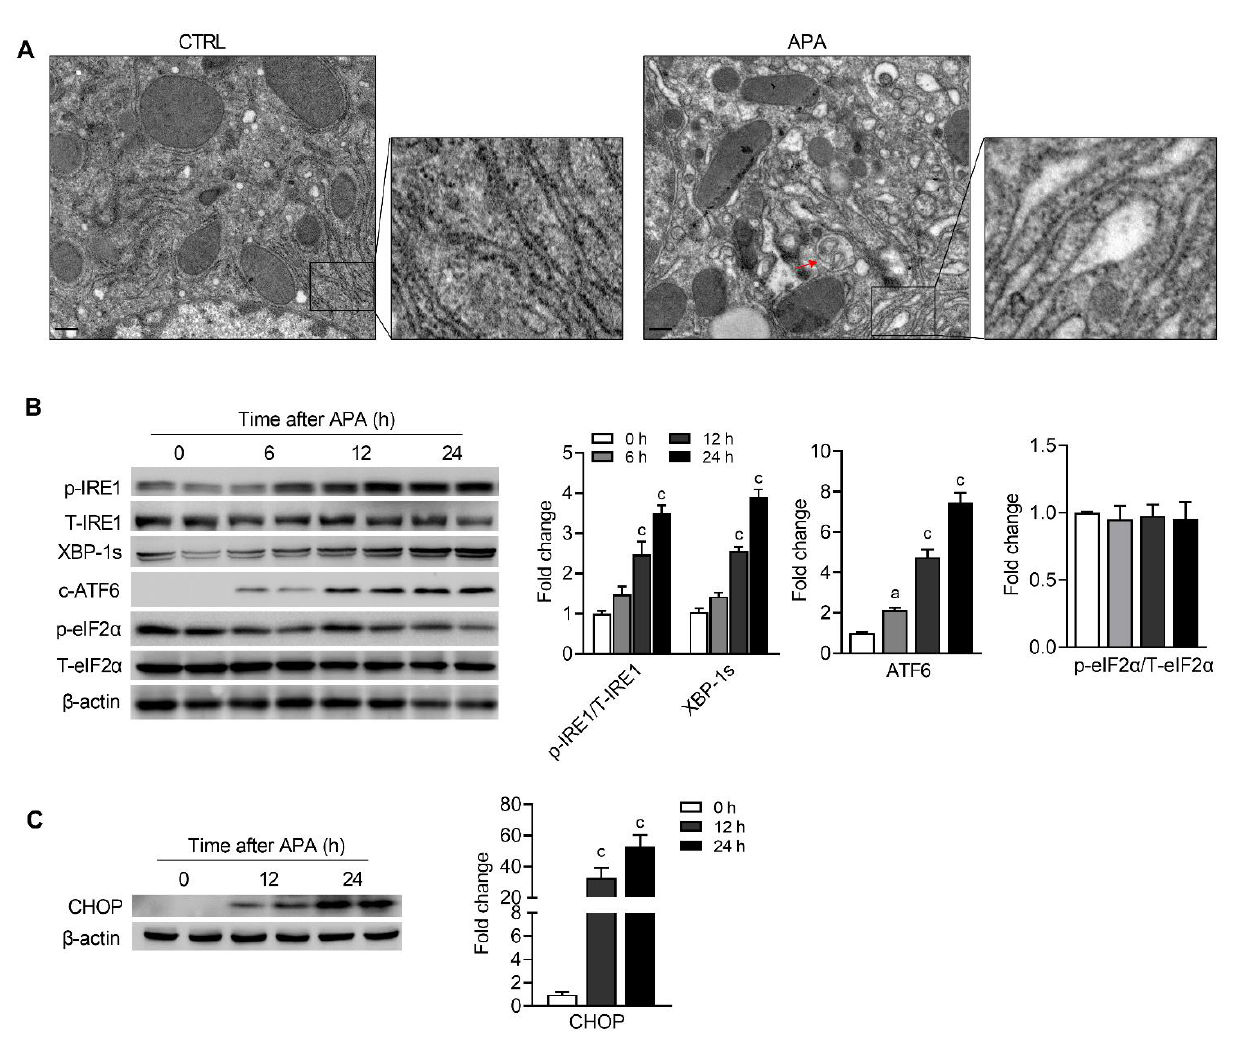
Figure 2. ER-phagy is activated and is accompanied with an unfolded protein response in APA hepatotoxicity. Mice were fasted for 16 h before injection with PBS or APA (300 mg/kg). At 6, 12 and 24 h post-APA, liver tissues were collected. ( A ) Representative TEM images of hepatocytes in mice liver at 24 h following PBS or APA injection. Scale bar = 400 nm. Arrows denote ER-selective autophagosomes. Immunoblot analysis for ( B ) p-IRE1, total IRE1, the sliced XBP-1, the cleavage of ATF6, p-eIF2α, total eIF2α and ( C ) CHOP at the indicated time points. Quantification of the phosphorylated proteins normalized to the corresponding total proteins bands, with the other protein bands normalized to the respective β-actin bands and, again, to the mean value of the control (CTRL) group are shown on the right. Data are presented as mean ± SEM. a: p < 0.05 and c: p < 0.001 compared with the vehicle control.